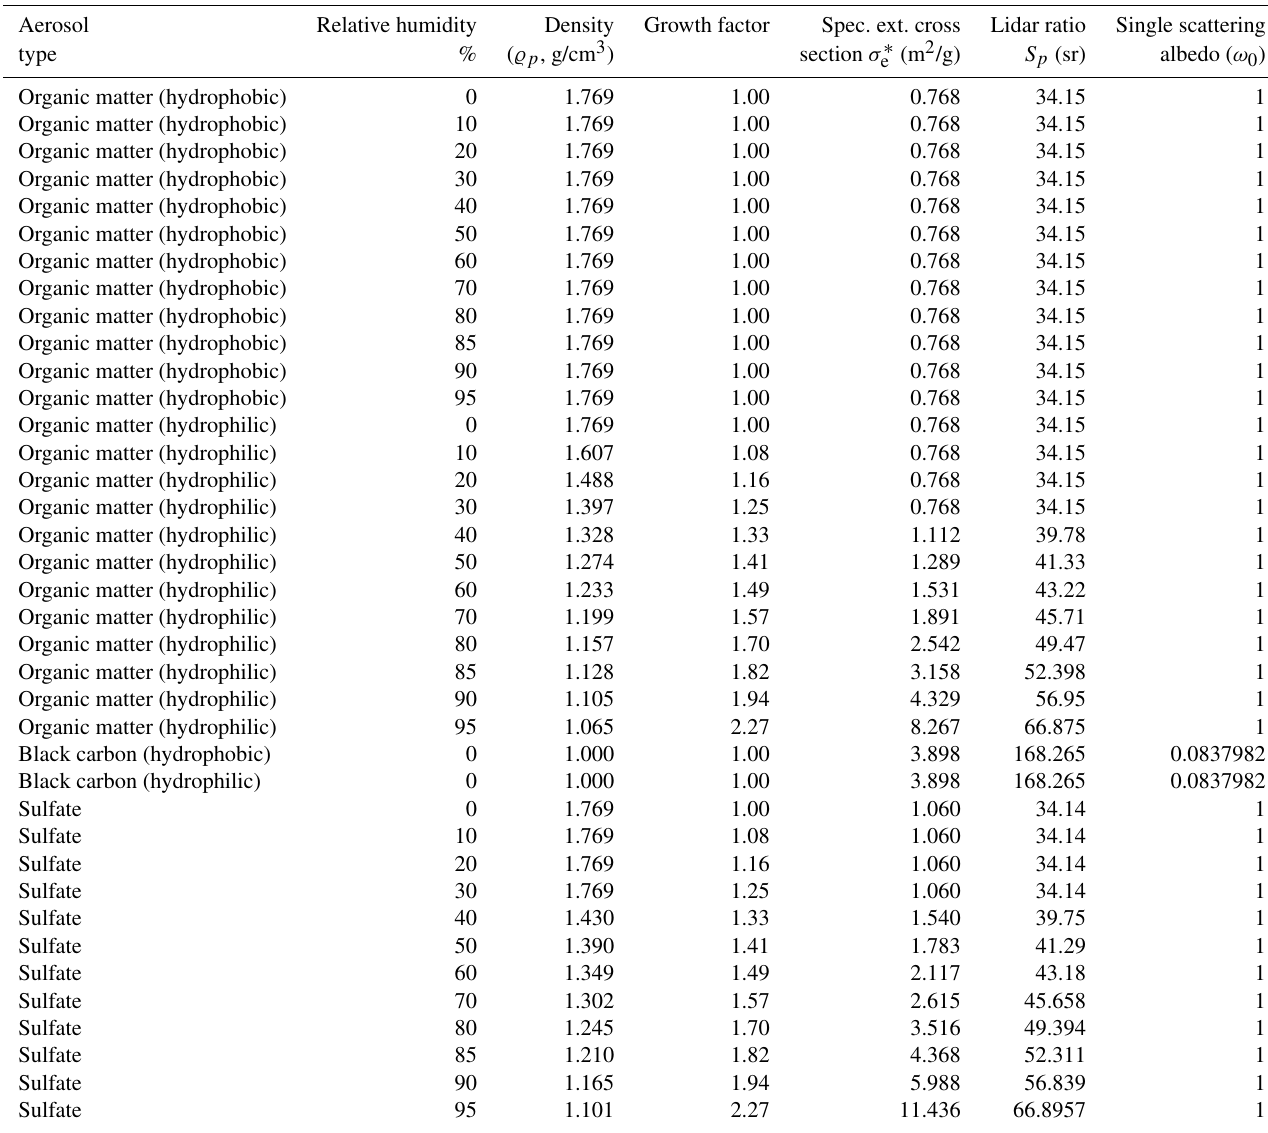
Table C2. Microphysical properties of aerosols assumed for conversion of model mass mixing ratios to β ∗ (z) at 1064nm. Aerosol Relative humidity Density Growth factor Spec. ext. cross Lidar ratio Single scattering type